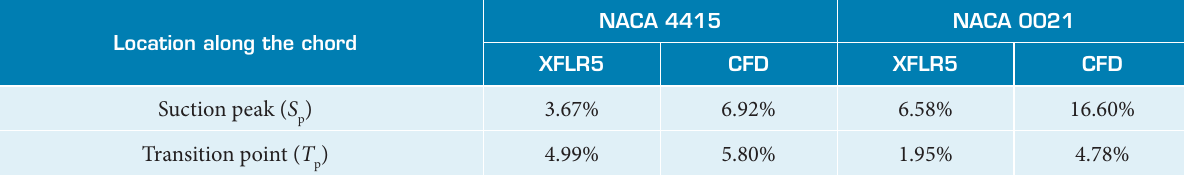
Figure 6. Comparison of pressure coefficients. (a) NACA 4415 at 6 o AoA; (b) NACA 0021 at 5 o AoA. Table 3. Percentage error difference between experiment and simulation